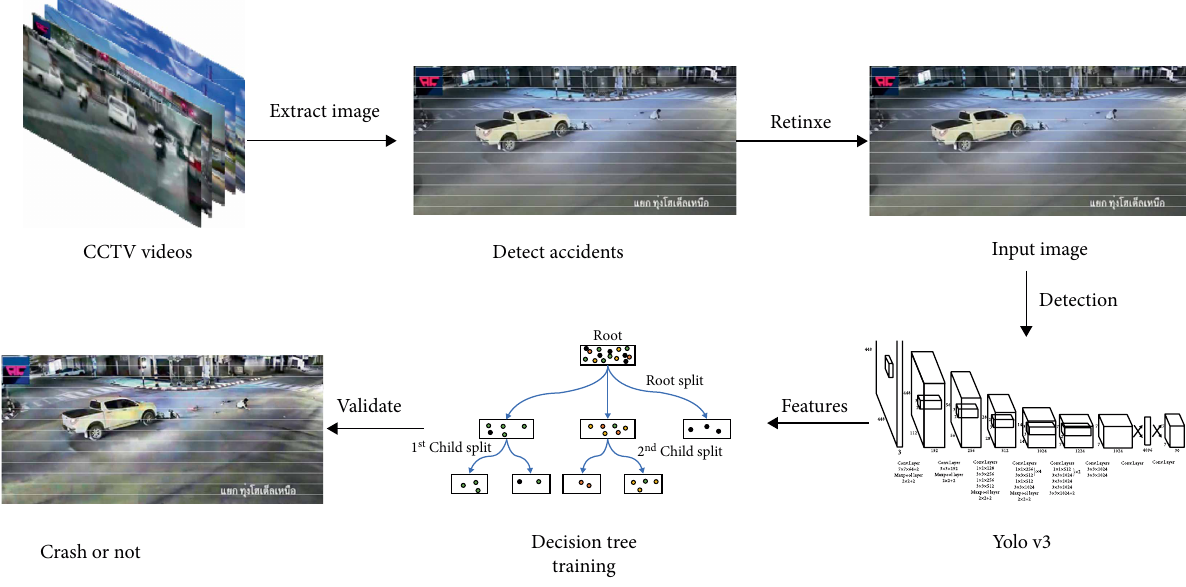
Figure 3: Crash detection framework for mixed traffic flow